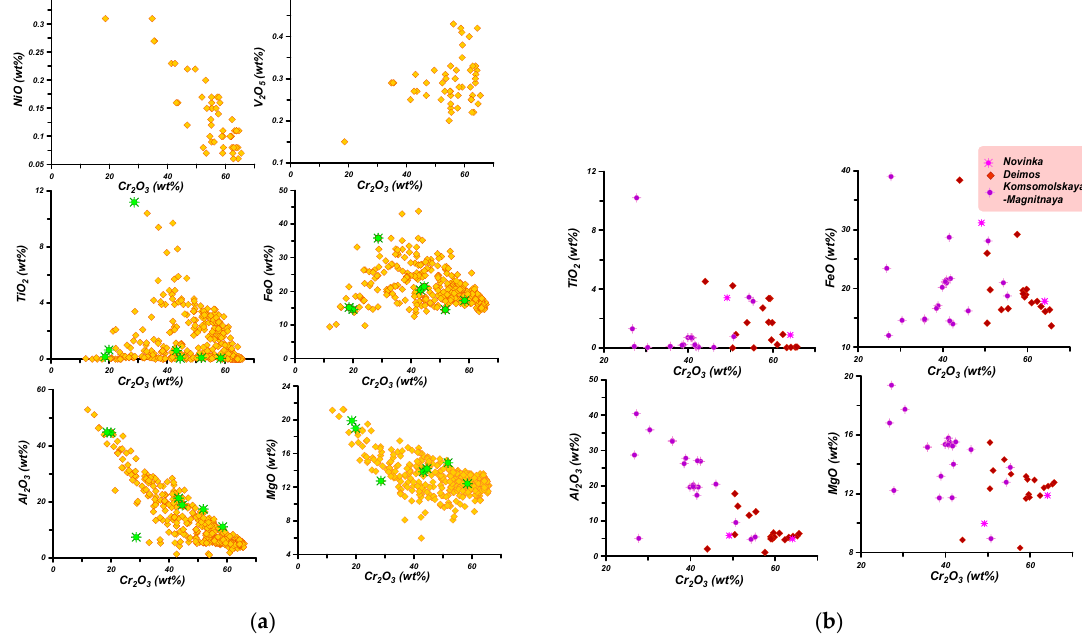
Figure 8. Compositions of chromites from Upper Muna field. ( a ) Zapolyarnaya; ( b ) Novinka, Deimos, and Komsomolskaya-Magnitnaya. Data for Novinka, Deimos, and Komsomolskaya-Magnitnaya are partly published [12].